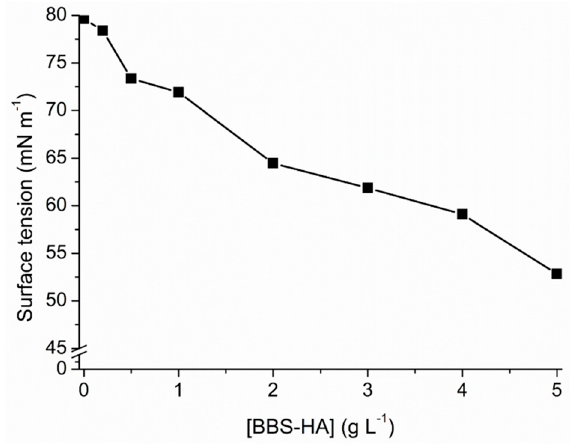
Figure 3. Surface tension vs. BBS-HA concentration.